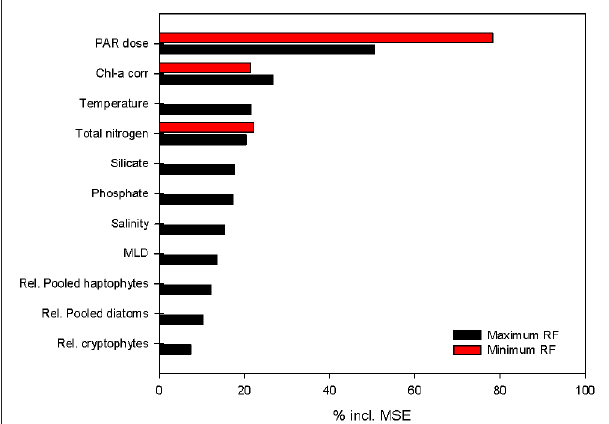
FIGURE 8 | Variable importance plot for the two random forest models build to estimate PP throughout the water column: R Fmax (black) and R Fmin (red). The x-axis shows the percentage of reductions in mean square error (MSE) per variable. All variables were included in the maximum model; daily PAR dose in the water column, phytoplankton biomass (chlorophyll a corrected for quenching), temperature, total nitrogen, silicate, phosphate, salinity, mixed layer depth (MLD based on maximum Brunt–Väisälä frequency) and relative abundance of the three most abundant phytoplankton groups. The minimum model excluded variables until a model was reached with the highest possible fit. The importance of the three remaining variables in this model is shown in